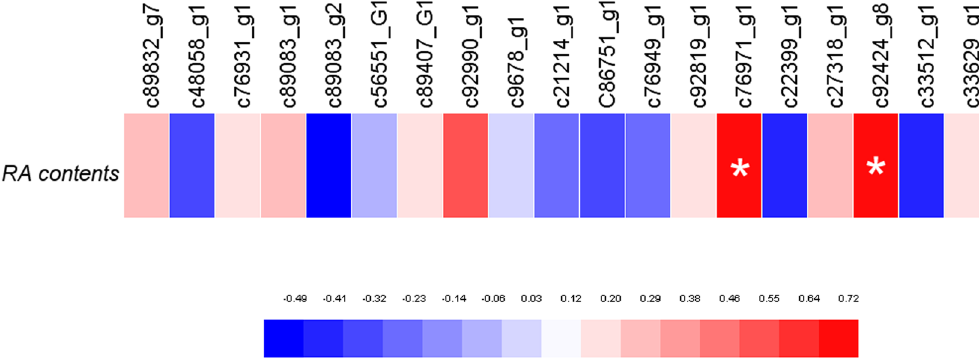
Figure 7. Pearson’s r correlation coefficient heat maps showing the association between RA contents and the expression of predicted biosynthetic genes related to RA in the six organs. A significance threshold of P < 0.005 was used, which is indicated by ‘ *